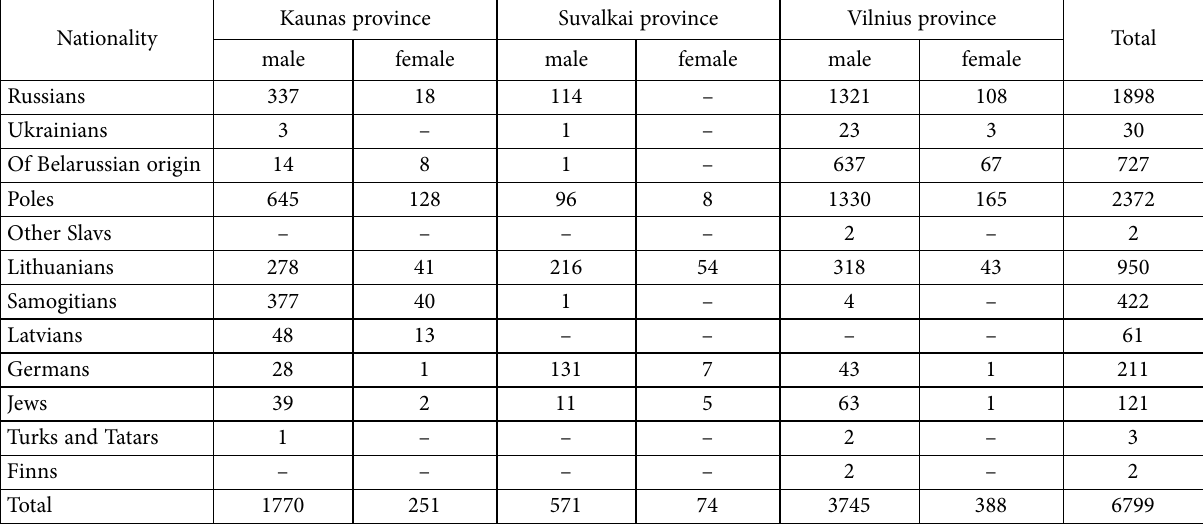
Table 4. The number of railway employees by nationality and gender in Lithuanian provinces (Žeimantas 2003)